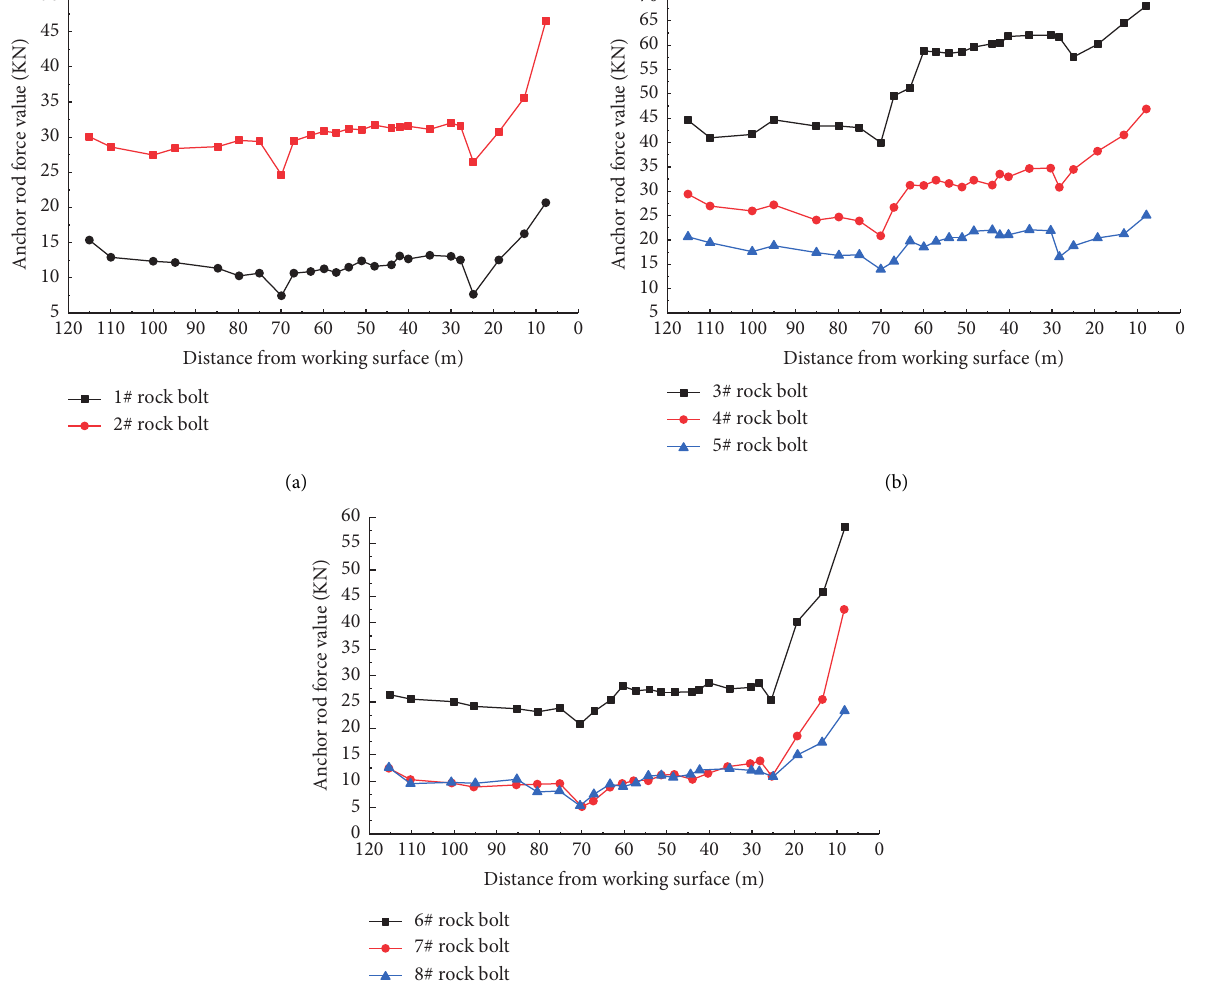
Figure 11: Stress characteristics of bolts in air-return roadway 5103. (a) Pillar side. (b) Roof. (c)